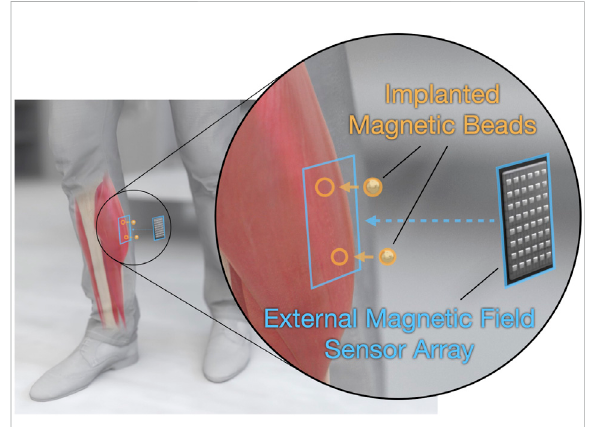
FIGURE 1 Trackingmuscletissuelengths via musclemagnetomicrometry. Magnetomicrometry tracks muscle tissue lengths in vivo , with potential prosthetic and exoskeletal control applications. A surgeon implants a pair of gold- and parylene-coated magnetic beads (highlighted in orange) into each muscle of interest. An external magnetic fi eldsensorarray(highlightedinblue)placedovereachpair ofimplantsthensensesthepassivemagnetic fi eldsfromtheimplants, andacomputerusesthesemagnetic fi eldmeasurementstocalculate the positions of the magnetic beads. The computer then calculates thedistancebetweenthetwobeads,providingareal-timeestimateof tissue